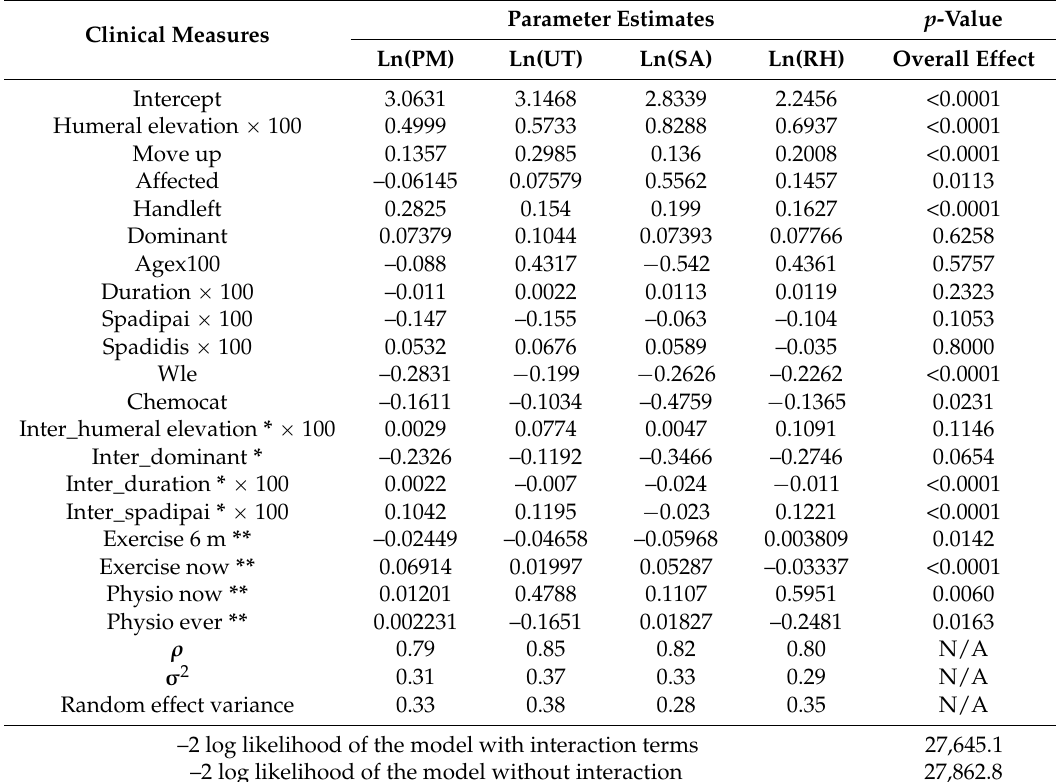
Table 2. Result of the analysis using univariate Linear Mixed Model with AR(1) structure for Σ k